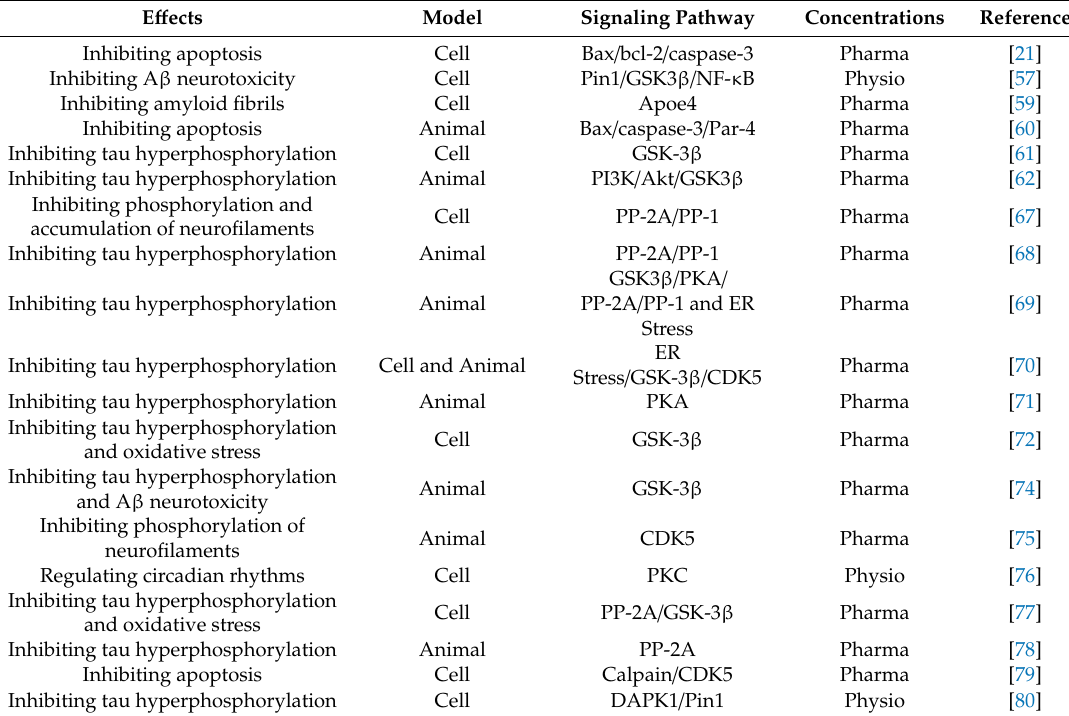
Table 1. Melatonin and Alzheimer’s